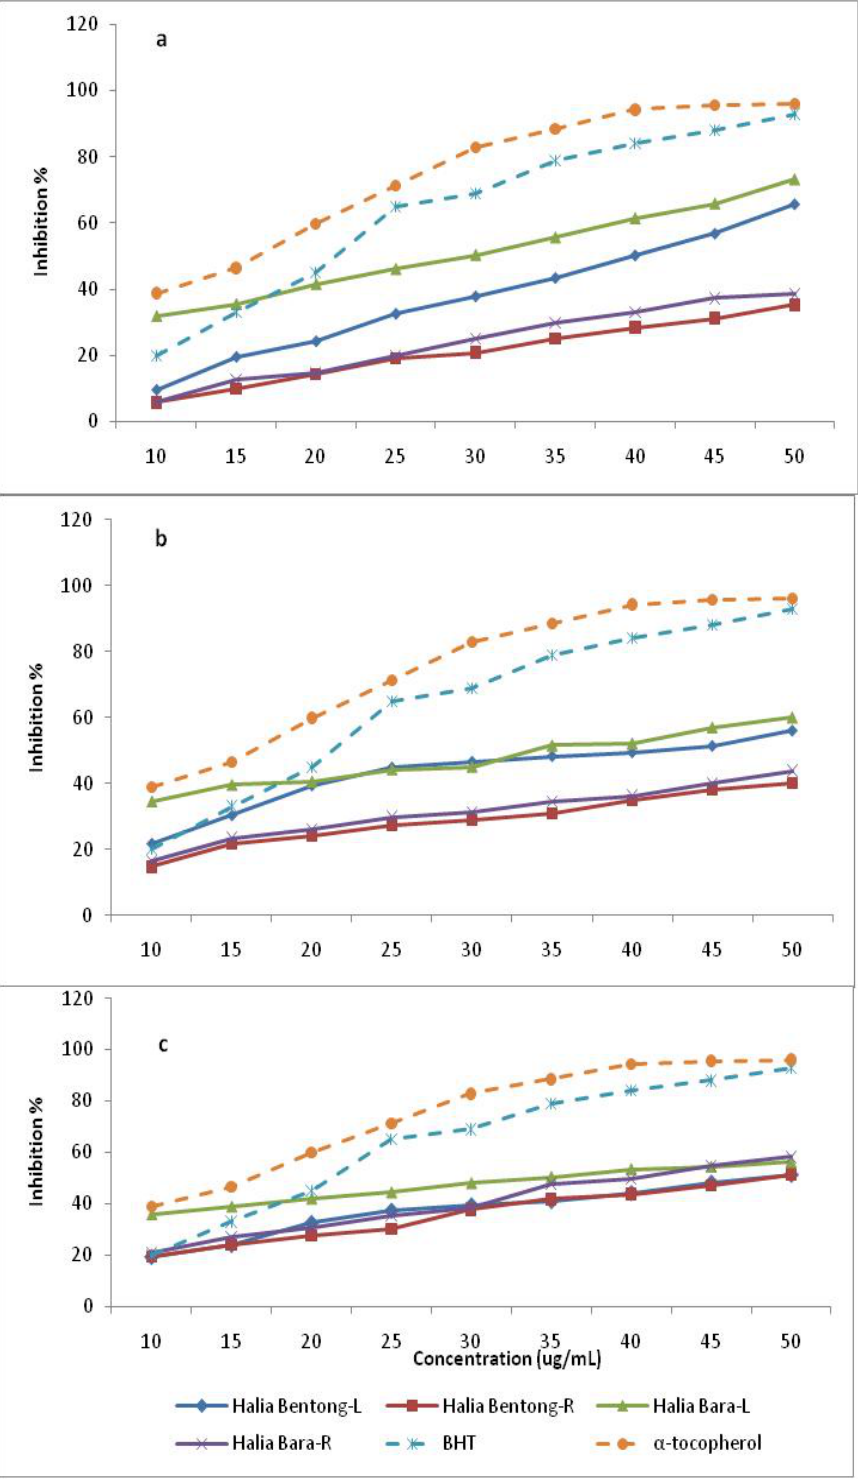
Figure 3. DPPH radical scavenging activity of the methanolic extracts in different parts of two varieties of Zingiber officinale during the growth period compared with positive controls, BHT and α -tocopherol. L and R represent leaves and rhizomes of ginger, respectively. a, b and c signify 8, 12 and 16 weeks after planting,